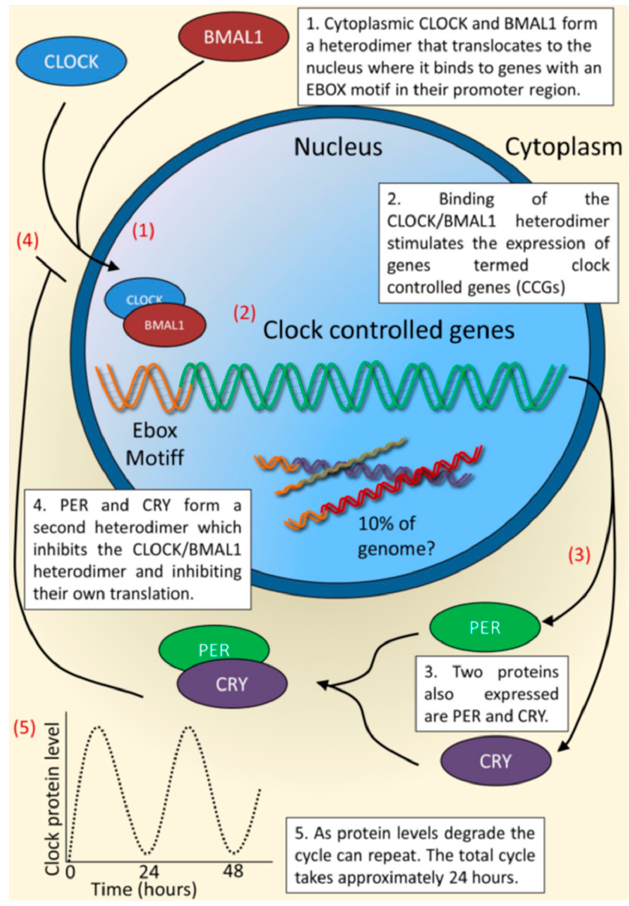
Figure 2. The core molecular clock system from Hardman et al. [23]. The figure shown describes a peripheral system in which the key elements in maintaining oscillations are shown. ( 1 ) The transcribed protein CLOCK and BMAL1 form a heterodimer, which translocates to the nucleus where it binds to genes containing an E-box motif in the promoter region or clock controlled genes (CCGs); ( 2 ) this binding leads to the transcription of CCGs and two families of proteins, the Period (PER) and Cryptochrome (CRY) family; ( 3 ) proteins PER and CRY form a second heterodimer, which prevents the formation of the first heterodimer and thereby inhibits their own transcription; ( 4 ) this cycle leads to an approximately 24 h oscillatory rhythm ( 5 ). Used with